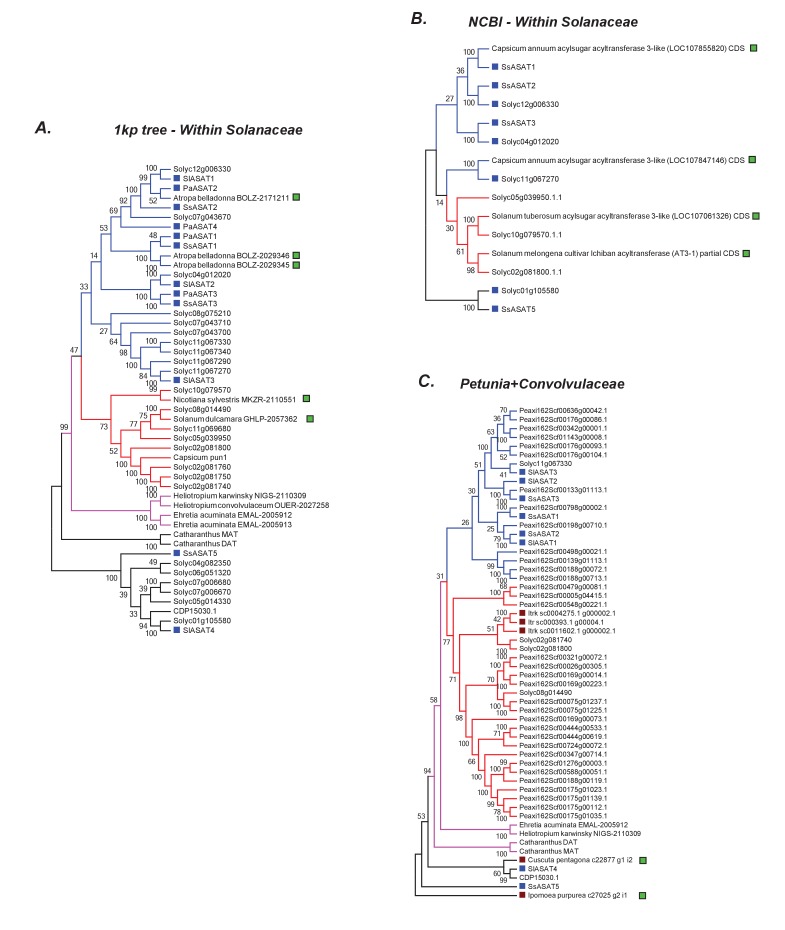
Additional related sequences do not affect our inferences regarding ASAT clade emergence.Hits obtained using various BLAST strategies (A,B) and using Petunia Clade III BAHDs (C) are shown in a phylogenetic context with ASATs and other relevant homologs. The novel hits that were not included in the final gene tree in Figure 6 are shown by a green square. All trees were generated using NJ, using the JTT model with 100 bootstraps. All sites with <80% coverage were eliminated.